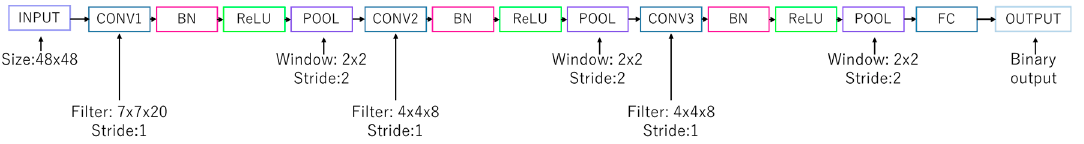
Figure 1. The CNN architecture employed in this study. We introduced batch normalization layers to accelerate learning.